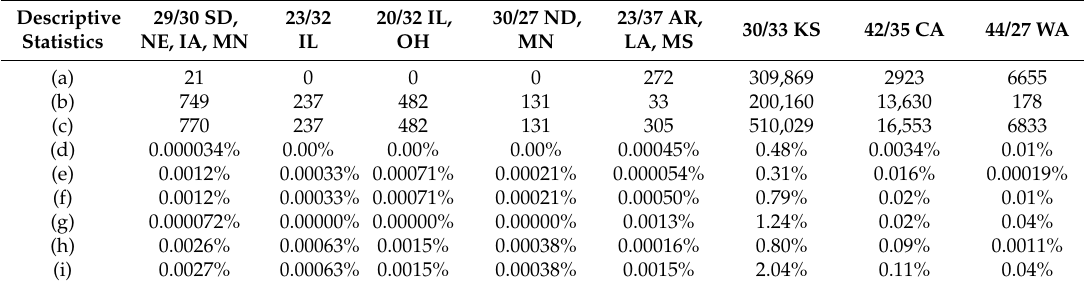
Table 2. ( a ) Total number of pixels identified as omission based on the model results; ( b ) Total number of pixels identified as commission based on the model results; ( c ) Total combined number of pixels identified as commission and omission based on the model results; ( d ) Total percentage of the pixels identified by the model as omission in NLCD 2006; ( e ) Total percentage of the pixels identified by the model as commission in NLCD 2006; ( f ) Total combined percentage of the pixels identified by the model as commission and omission in NLCD 2006; ( g ) Total percentage of the pixels identified by the model as omission for cultivated crops (Class 82) in NLCD 2006; ( h ) Total percentage of the pixels identified by the model as commission for cultivated crops (Class 82) in NLCD 2006; ( i ) Total combined percentage of the pixels identified by the model as commission and omission for cultivated crops (Class 82) in NLCD